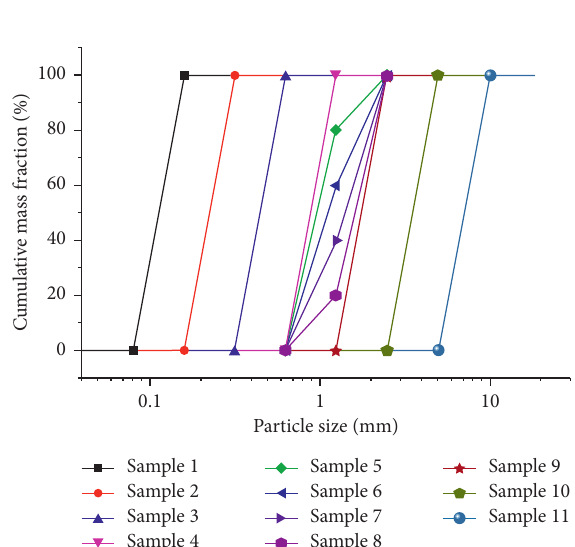
Figure 3: The grain-size distribution curve of the sand sample.